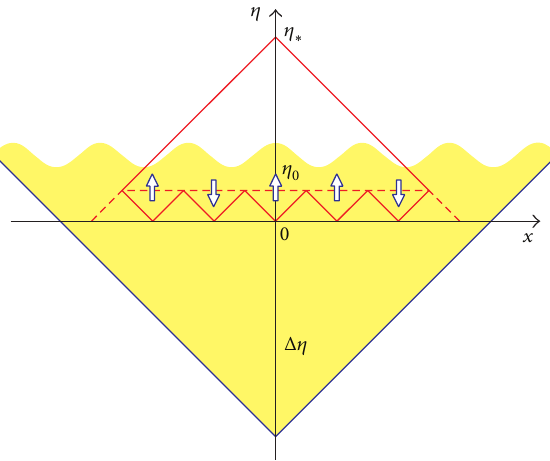
Figure 6: Conformal diagram of 1D FRW cosmological